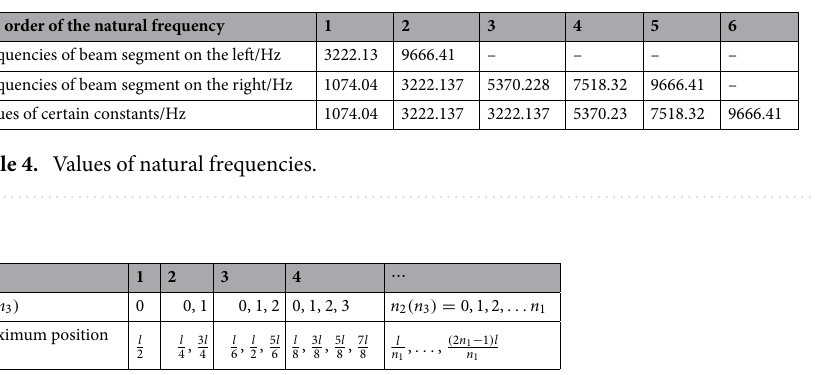
Table 5. Maximum position.